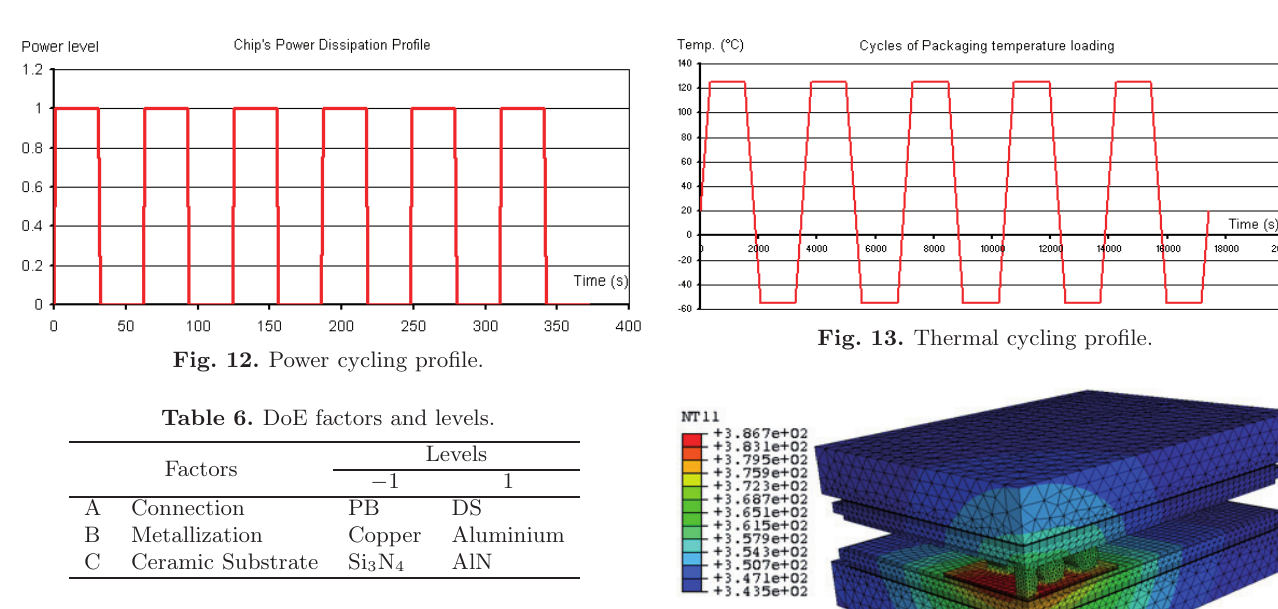
Fig. 11. Elementary power bump (a) and direct solder (b) modules finite elements models.